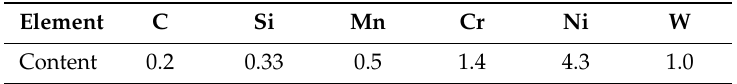
Table 1. Elemental content (mass fraction) of the 18Cr2Ni4WA